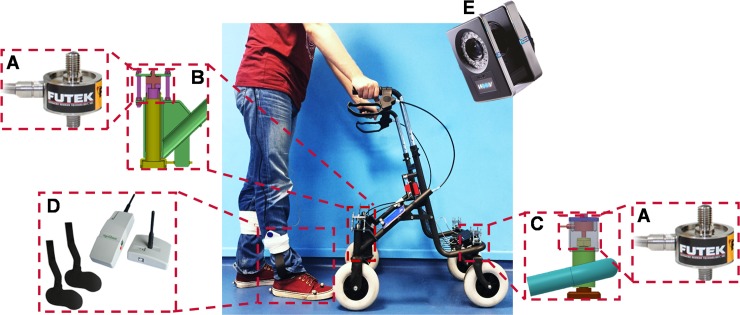
Instrumented rollator system.Details of: A) load cell; B) rear leg design; C) front leg design; D) pressure-sensing insole system; E) infrared camera.